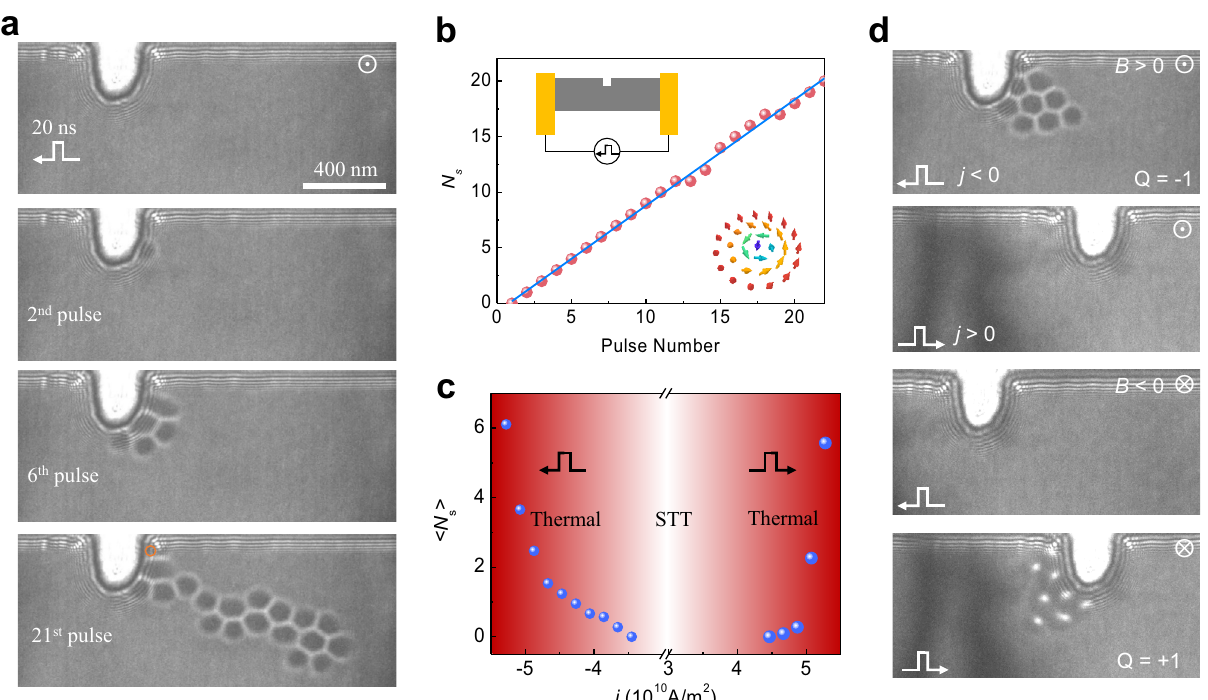
Fig. 1 Skyrmion creation with a notch. a A sequence of Lorentz TEM images of the skyrmion creation process after applying designated numbers of current pulses. After the 2nd, 6th, and 21st pulse, the created skyrmions are 1, 5, and 19, respectively. The depth and width of the notch are 280 nm and 190 nm, respectively. The orange circle highlights a skyrmion at the corner. b The number of created skyrmions as a function of pulse numbers. Inset: Schematic plots of the experimental setup (upper left) and a magnetic skyrmion (lower right). c The average numbers of created skyrmions per current pulse as a function of current density. The creation rate is asymmetric with respect to the current direction, especially in the STT-dominated region. The scale bar in ( a ) is 400 nm. d Unidirectional skyrmion creation in the STT-dominated regime. Skyrmions with the topological charge of Q = − 1 (Q = + 1) are created on the right (left) side of the notch under a negative (positive) j and a positive (negative) external fi eld B . No skyrmion is created under the combinations j > 0, B > 0, and j < 0 ; B < 0. The unidirectional skyrmion creation originates from the unique direction of the spin precession that breaks the re fl ection symmetry. (cid:6) and .. stand for the upward and outward directions of the external magnetic fi eld, respectively. The amplitude of the magnetic fi eld is B = 70 mT, and the current density is j j j ¼ 4 : 26 ´ 10 10 A (cid:3) m (cid:1) 2 and pulse width 20